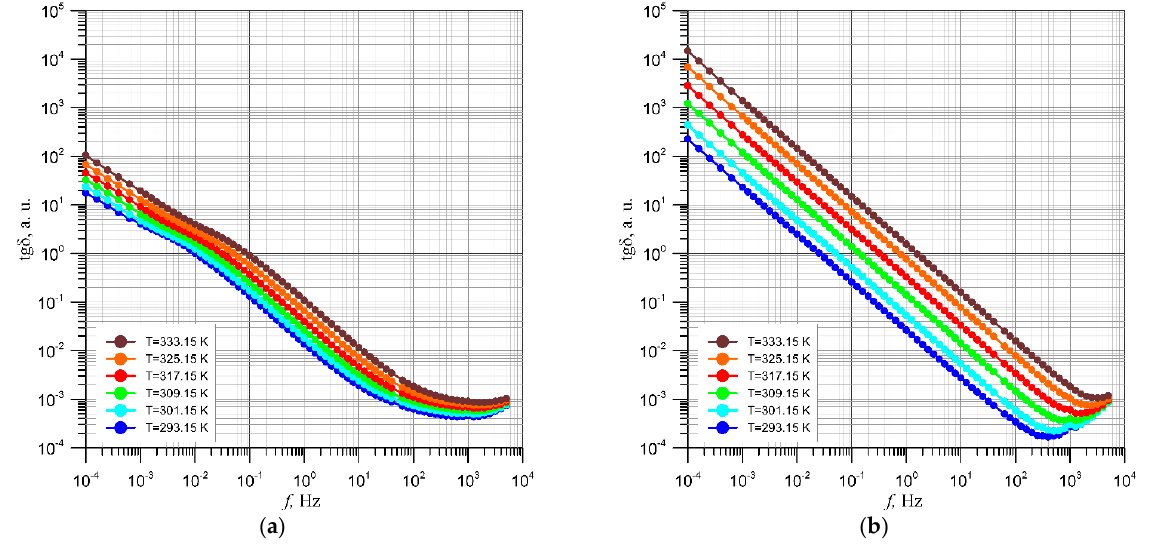
Figure 5. Frequency dependencies of the loss tangent of mineral insulating oil with a moisture content of 5 pm—( a ) and moistened mineral oil—( b ) at temperatures from 293.15 K to 333.15 K in steps of 8 K.